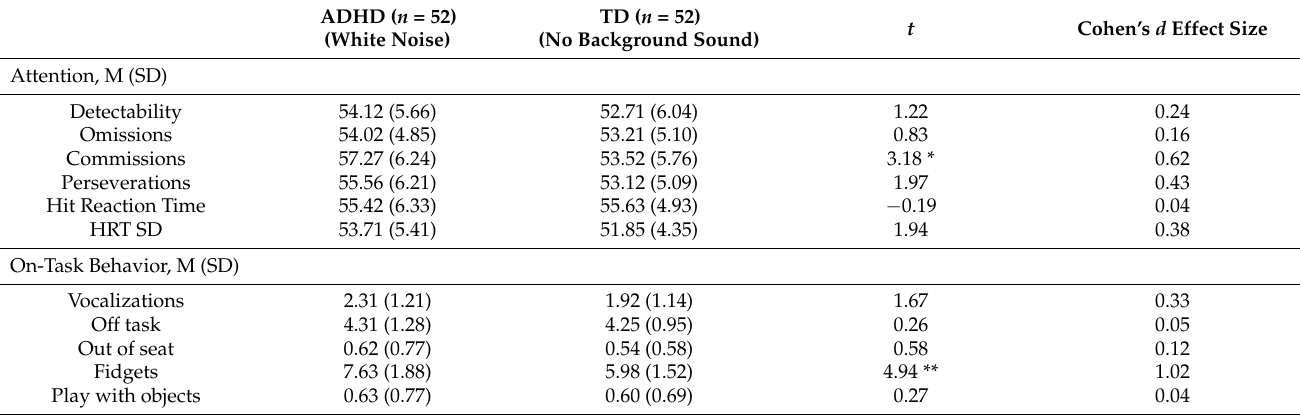
Table 3. Comparison of intrinsic and extrinsic performance between ADHD preschoolers in “white noise” condition and TD preschoolers in “no background sound” condition.